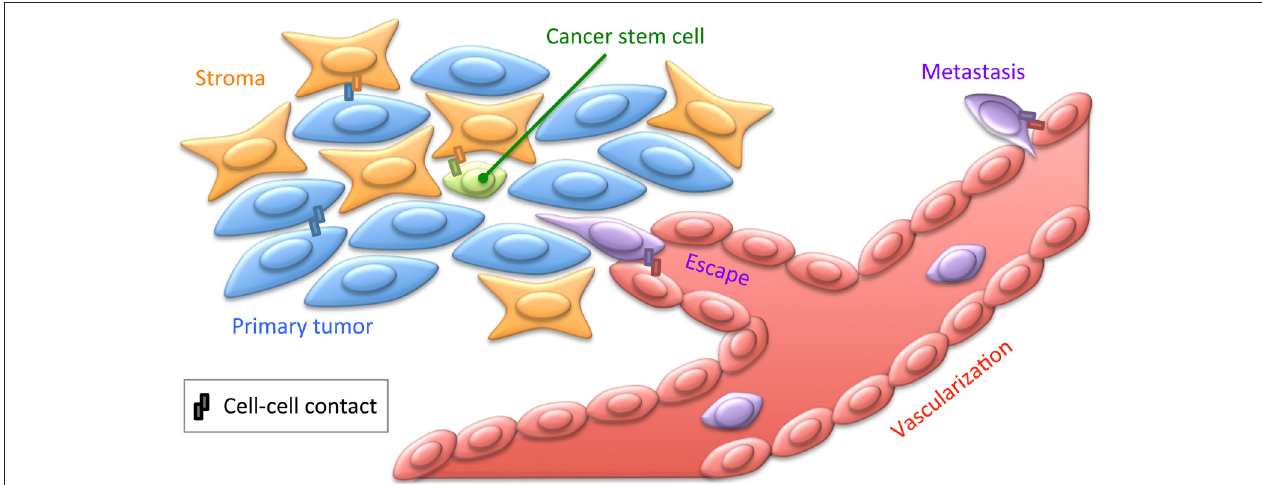
FIGURE 2 | Cell contacts in cancer. Cancer cells engage contacts with themselves as well as with their surrounding stroma, including the ECM. Tumors are believed to contain cancer stem cells, engaging privileged contacts with the stroma allowing them not only to maintain quiescence and pluripotency, but also to putatively sustain resistance to chemotherapy. Cancer cells may also engage specific contacts with the tumor neovascularization. This may lead to cancer cell escape within the blood or lymph circulation by intravasation, and subsequently to distant metastasis by extravasation ( Reymond et al., 2013). These various cellular interactions implicate a broad range of CAMs, such as cadherins, integrins, or JAMs, as well as ECM and soluble factors. Most of these cancer-specific contacts thus provide privileged strategies for immunotherapeutic treatments to target tumoral cells with monoclonal antibodies directed against integrins for instance (Scott et al.,